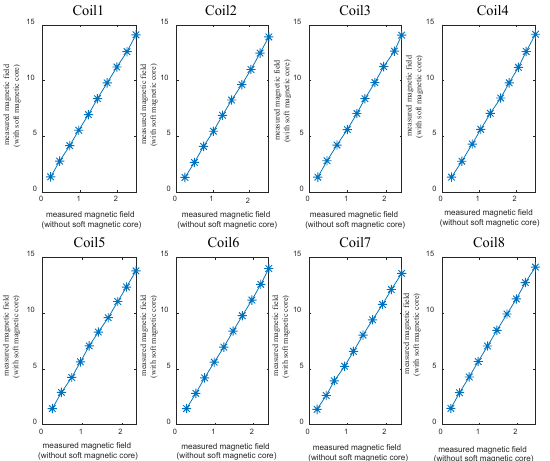
Figure 4. The linear enhancement of the magnetic field distribution by the soft magnetic core in a single coil